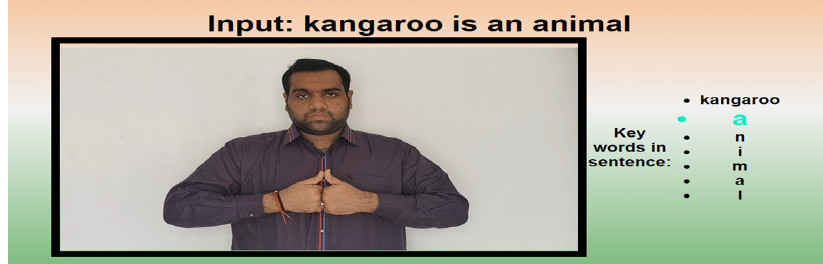
Figure 13. Case 5. Available video for ‘kangaroo’.